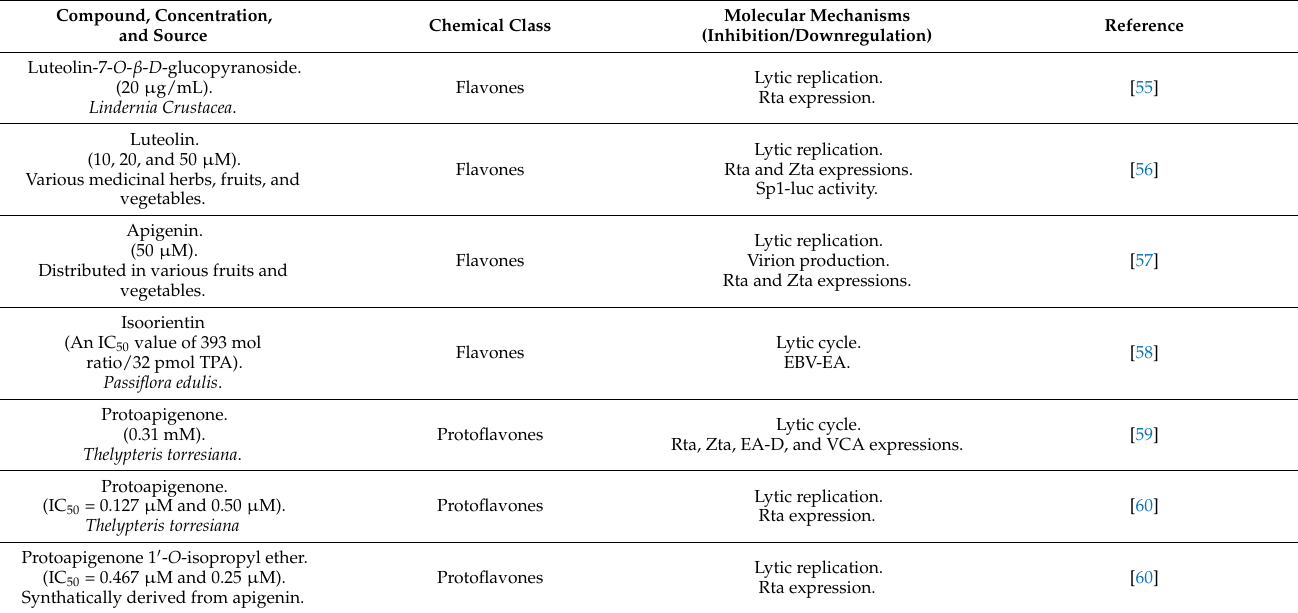
Table 1. Flavonoids with anti-EBV properties and their molecular mechanisms assayed in vitro and in